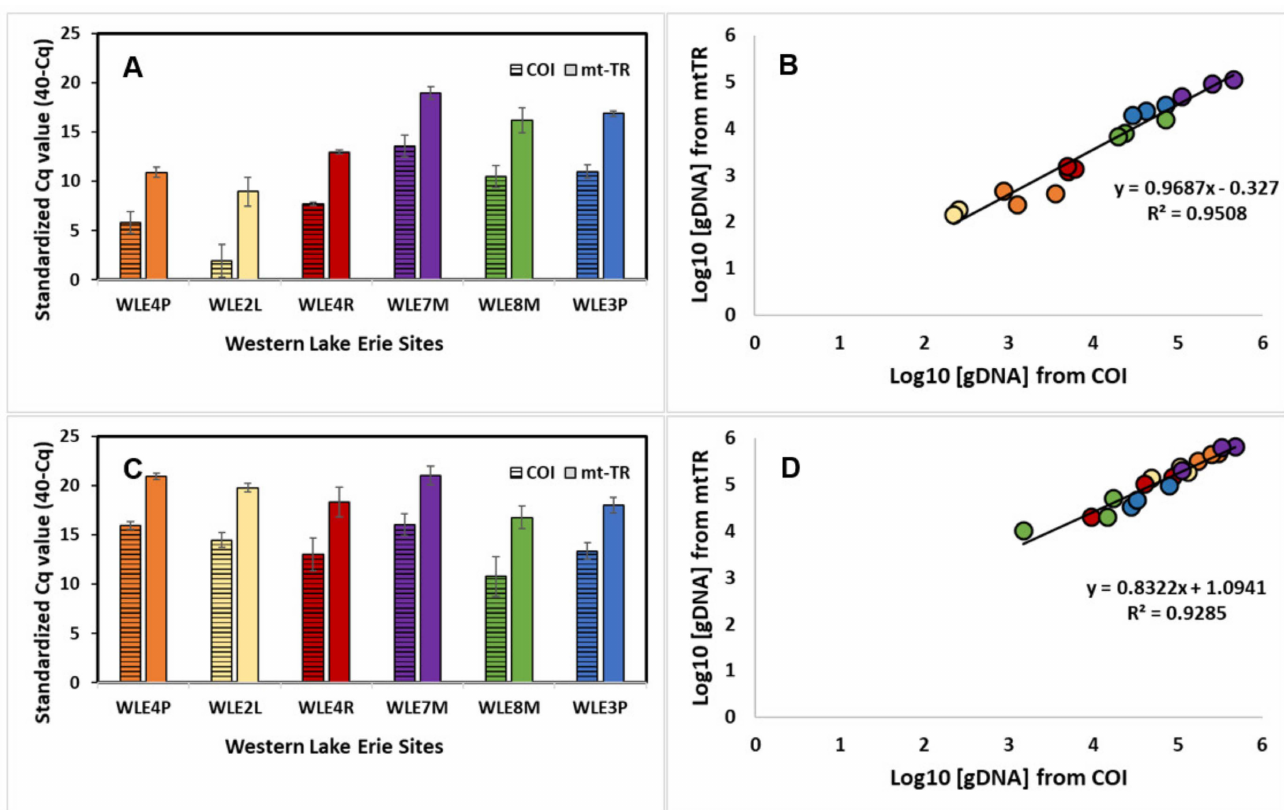
Figure 4. Standardized Cq values ( ± standard deviation) for ( A ) zebra mussels ( Dreissena poly- morpha ) and ( C ) quagga mussels ( D. rostriformis ) for a mitochondrial cytochrome oxidase I (COI) assay (Blackman et al. 2020) (lined bar) and a newly developed mitochondrial tandem repeat (mtTR) assay (filled bar) across the six western Lake Erie sampling sites. The relationship of quanti- fied genomic DNA (log10 of fg/ µ L) between the COI and mtTR assay for ( B ) zebra mussels and ( D ) quagga